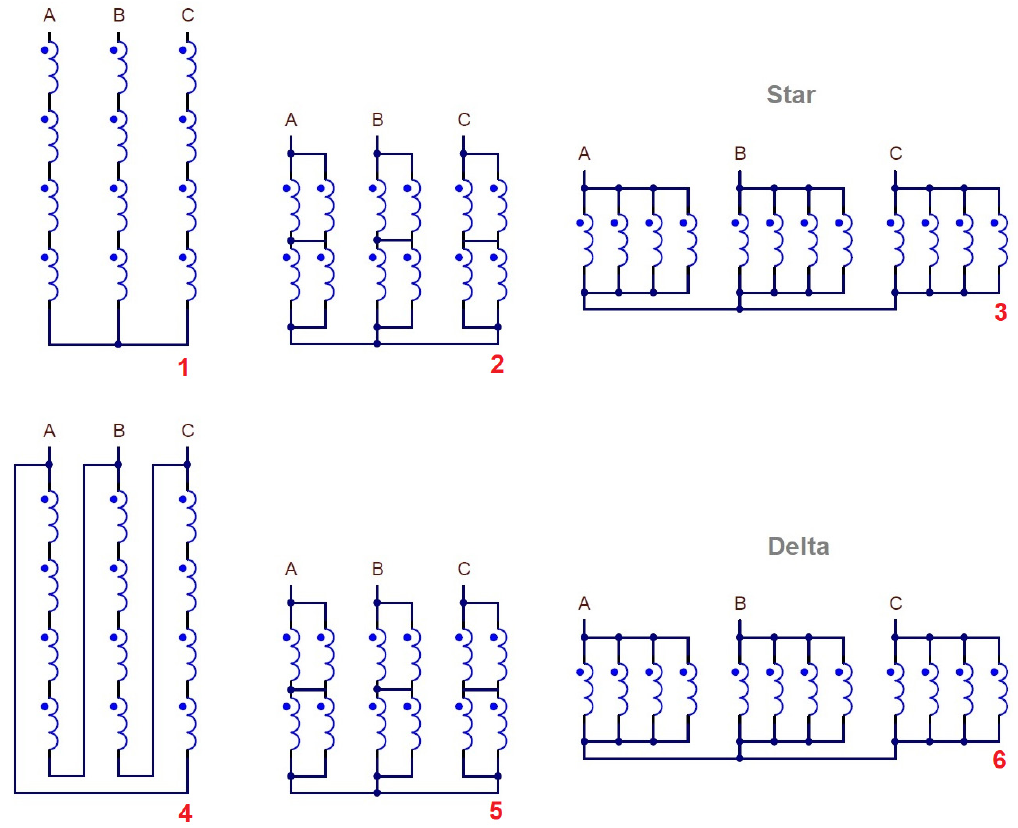
Figure 6. Six possible winding switching schemes . Switching during the operation of the BLDC motor of various winding connection schemes is similar to an automatic transmission in a car when the transmission stages are switched depending on the required dynamic characteristics of the ride. Such a switch can also be made by a control signal from the operator, which is similar to manual transmis- sion in a car. Since all three phases must be switched simultaneously, for switching all 27 switching elements, there have been used 9 control signals that come from a diode matrix, where the signal of switching a particular circuit of the windings (IN1-IN3) is divided into separate switching elements S1–S9, see Figure 7.